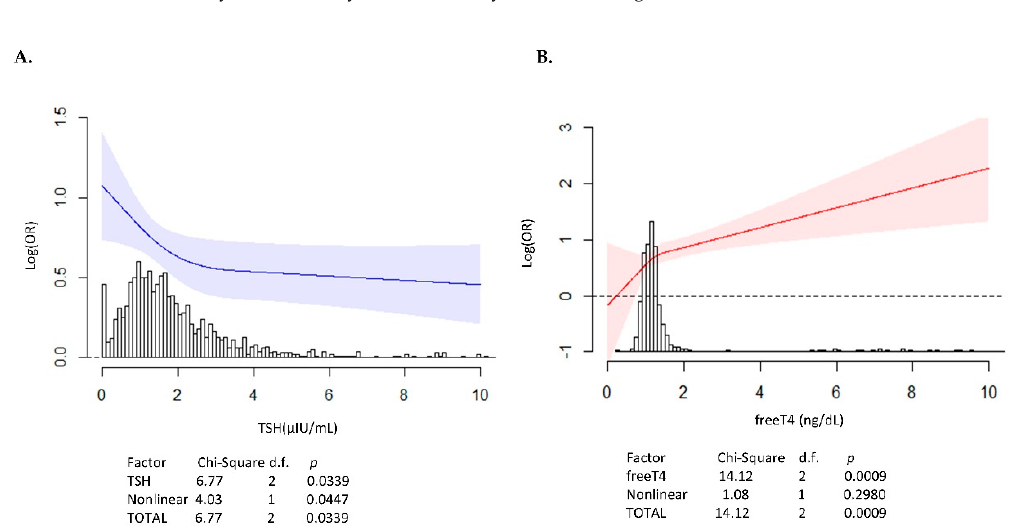
* The multivariate logistic regression analysis was performed with variables with predictive significance ( p < 0.05) of VA in univariate analysis except free T4 concentration. CAD, coronary artery disease; CI, confidence interval; OR, odds ratio; T3, triiodothyronine; T4, thyroxine; TSH, thyroid stimulating hormone.